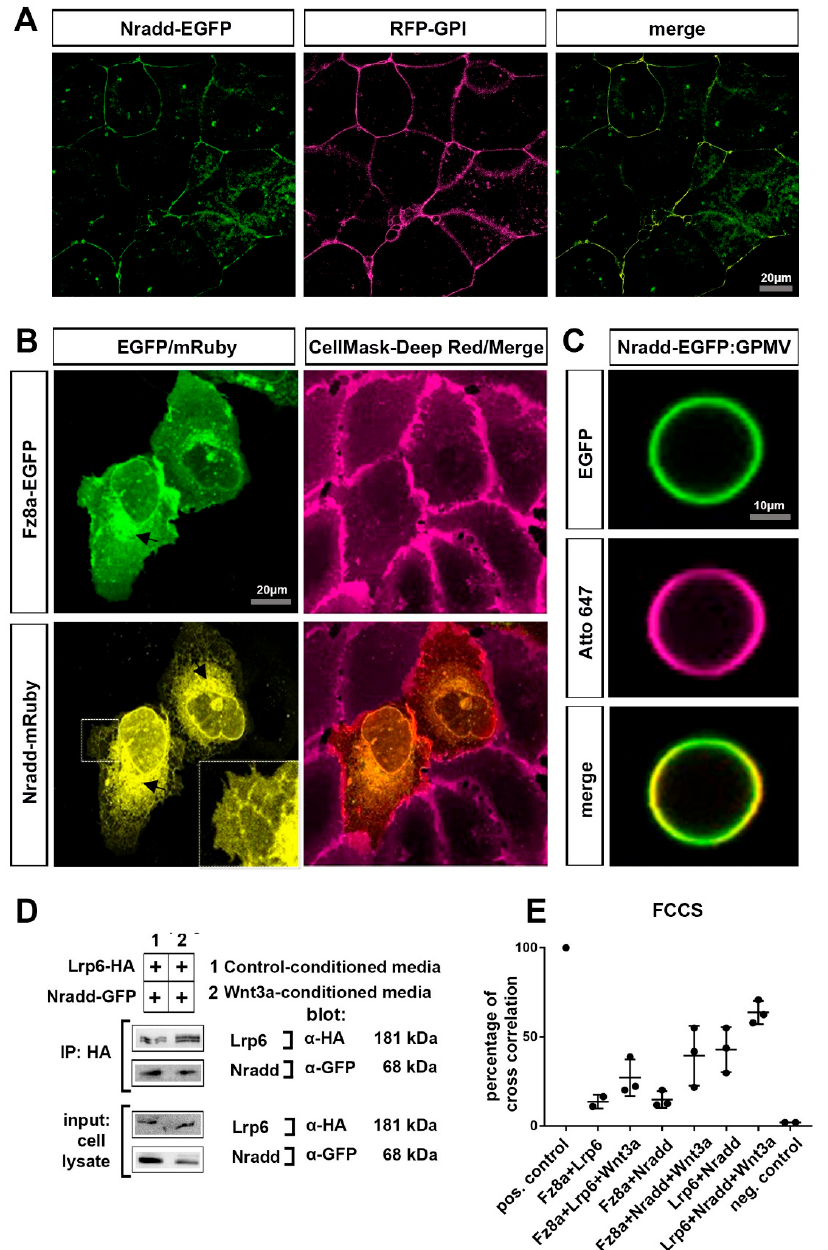
Figure 4. Nradd localizes to the plasma membrane and interacts with the Wnt–receptor complex ( A ) Nradd-EGFP (green) and RFP-GPI (red) localize at the plasma membrane of the enveloping layer cells of zebrafish embryos at 4 hpf (dome stage). ( B ) In U2OS cells, Fz8a-EGFP (green) co-localizes with the CellMask Deep Red (red) at the plasma membrane while Nradd-mRuby (yellow) localizes to the ER, but a significant fraction of it is in the plasma membrane, as seen from the zoom-in inset image. Arrows indicate protein transport from the ER to the plasma membrane. ( C ) Nradd-EGFP (green) localizes to the surface of cell-derived giant plasma membrane vesicles (GPMVs) and overlaps with the plasma membrane marker Atto647N-PE (red). ( D ) Nradd-GFP co-immunoprecipitates with Lrp6-HA in HEK293T cells. Three independent experiments were performed. ( E ) Fluorescence cross-correlation spectroscopy (FCCS) measurements show cross-correlation percentages between Fz8a-Lrp6, Fz8a-Nradd and Lrp6-Nradd, with/without Wnt3a stimulation at the plasma membrane. Nradd co-diffuses with Fz8a and Lrp6 at the membrane and this co-diffusion is enhanced by Wnt3 stimulation. EGFP and mCherry proteins were used as negative controls and their cross-correlation percentage is